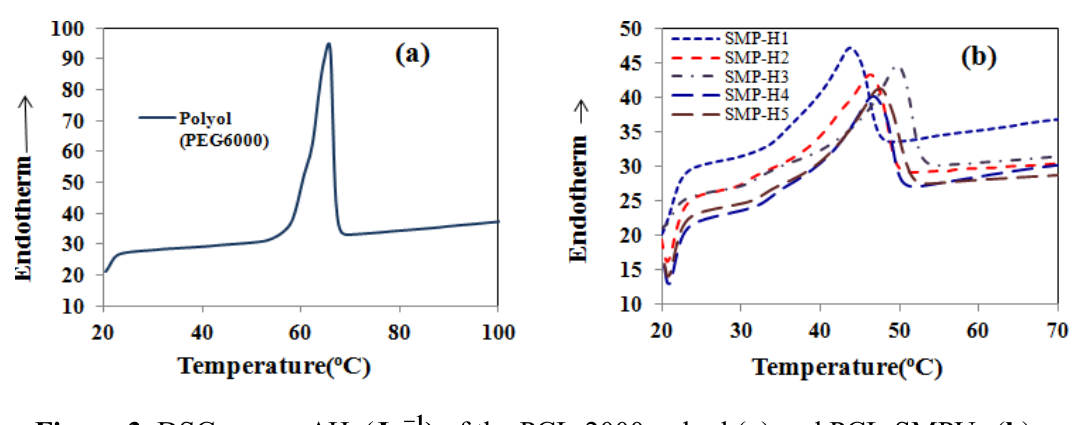
Figure 3. DSC curves Δ H ( Jg − 1 ) of the PCL-2000 polyol ( a ) and PCL-SMPUs ( b f